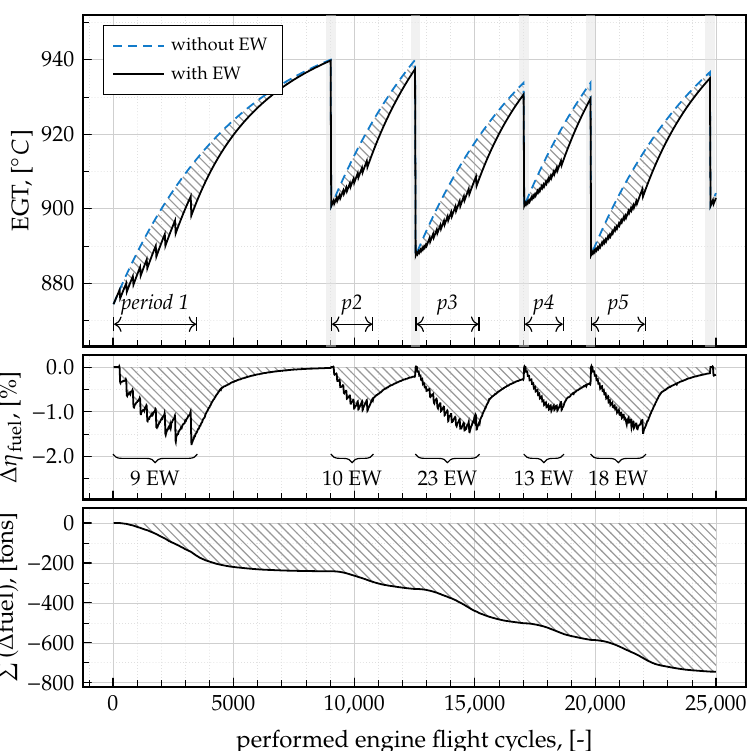
Figure 18. Effects of EW on the EGT ( top ), fuel efficiency ( center ), and accumulated fuel burn ( bottom